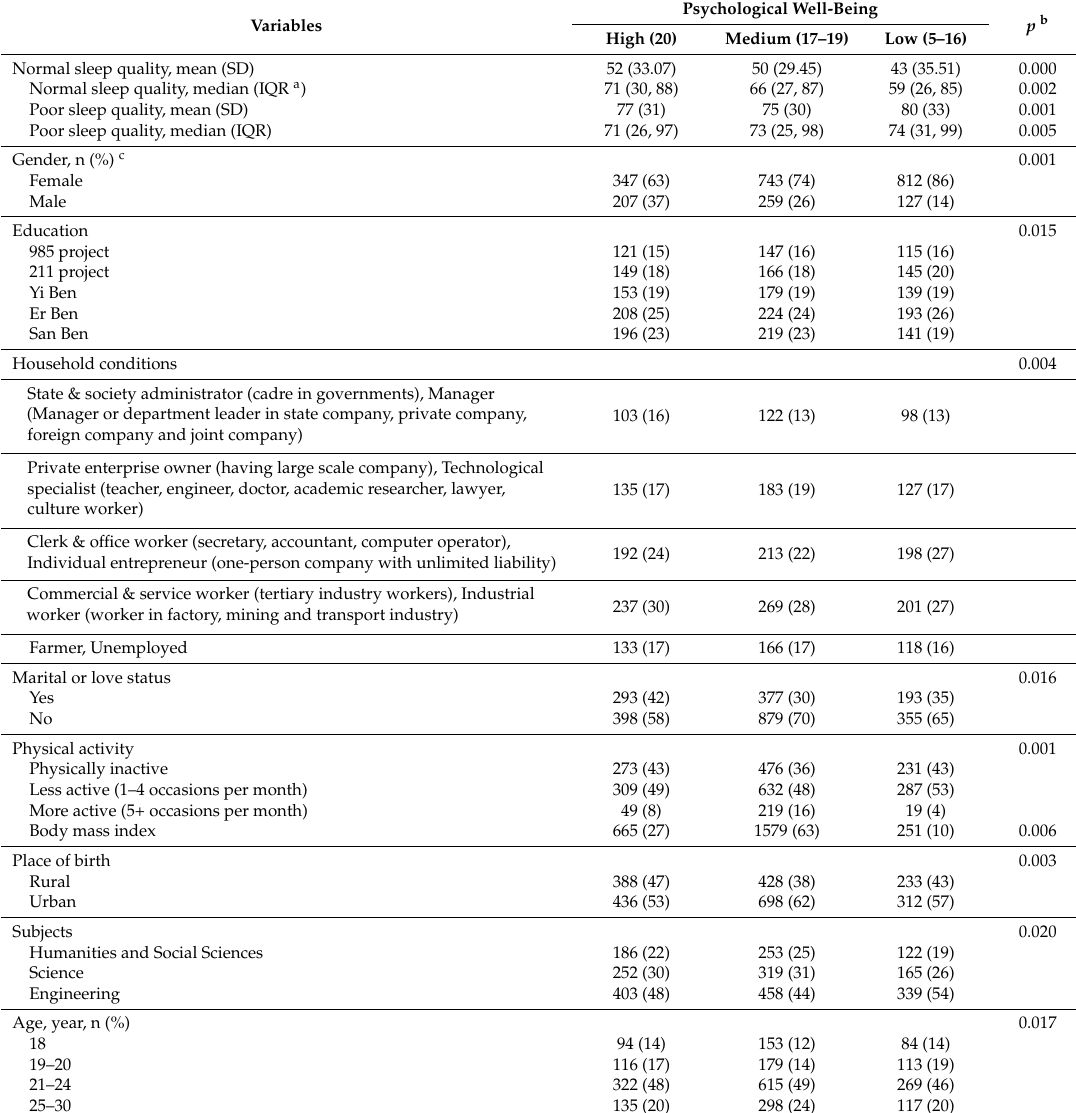
Table 2. Whole sample characteristics & bivariable associations ( N =